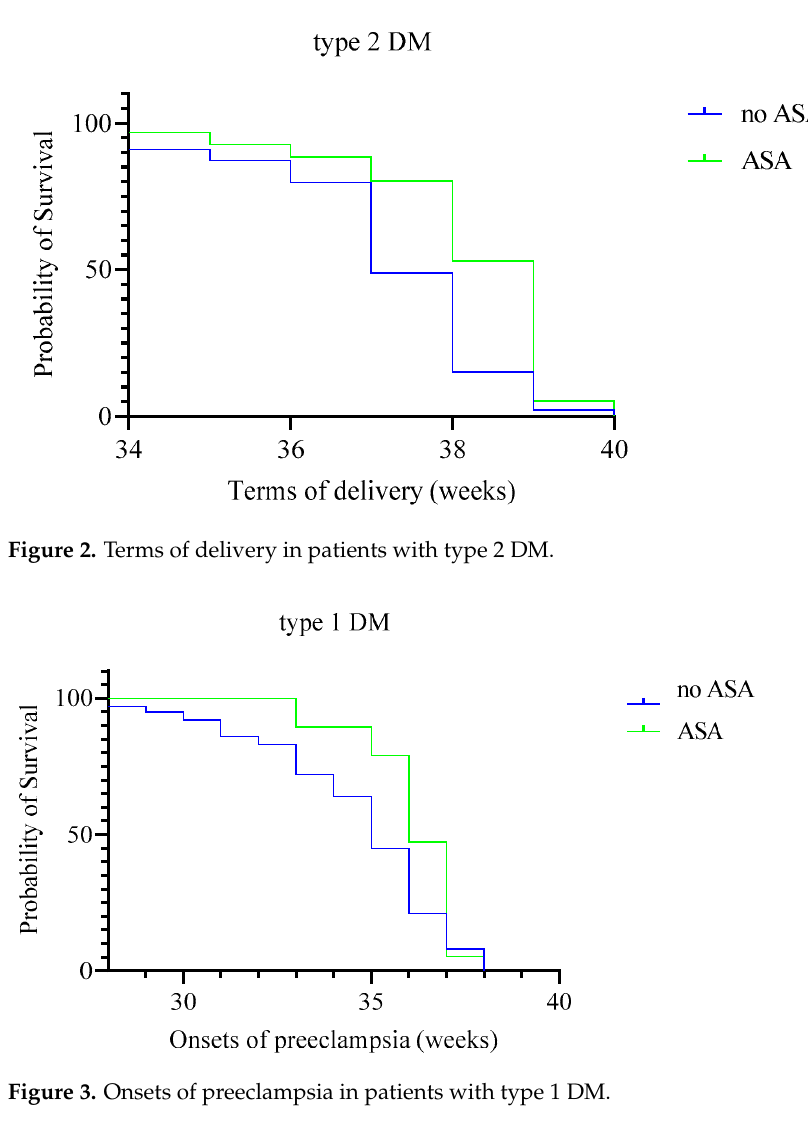
Figure 3. Onsets of preeclampsia in patients with type 1 DM.